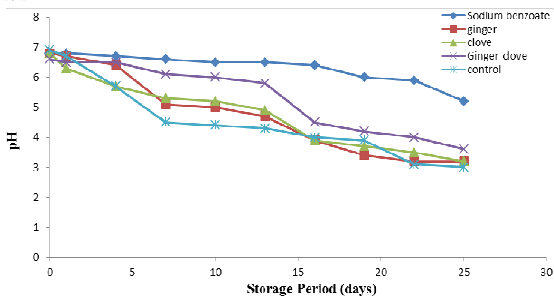
Fig. 8. Effects of different treatments on pH of soymilk samples at 3% concentration stored at refrigerated temperature for 25 days